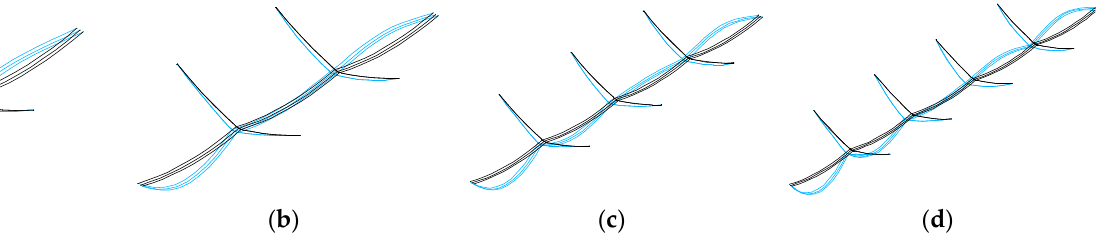
Figure 7. Frequencies of vibration modes of multi-span CRS.